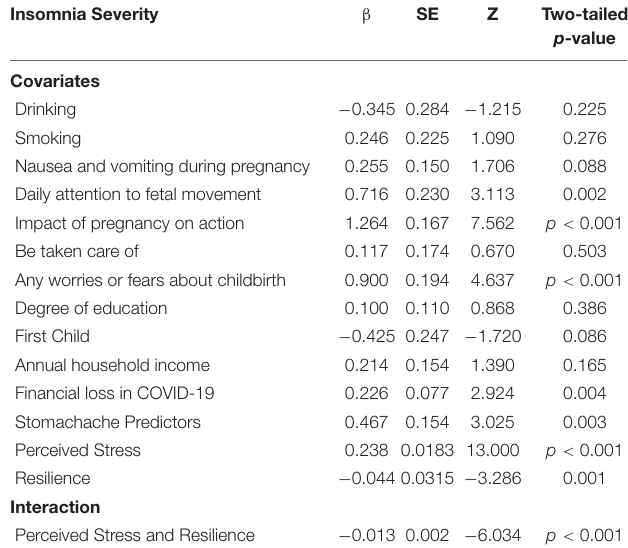
TABLE 3 | Regression analysis examining the role of Perceived Stress in predicting Insomnia